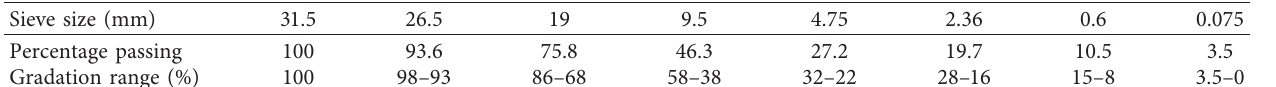
Table 3: Gradation of aggregate [32].